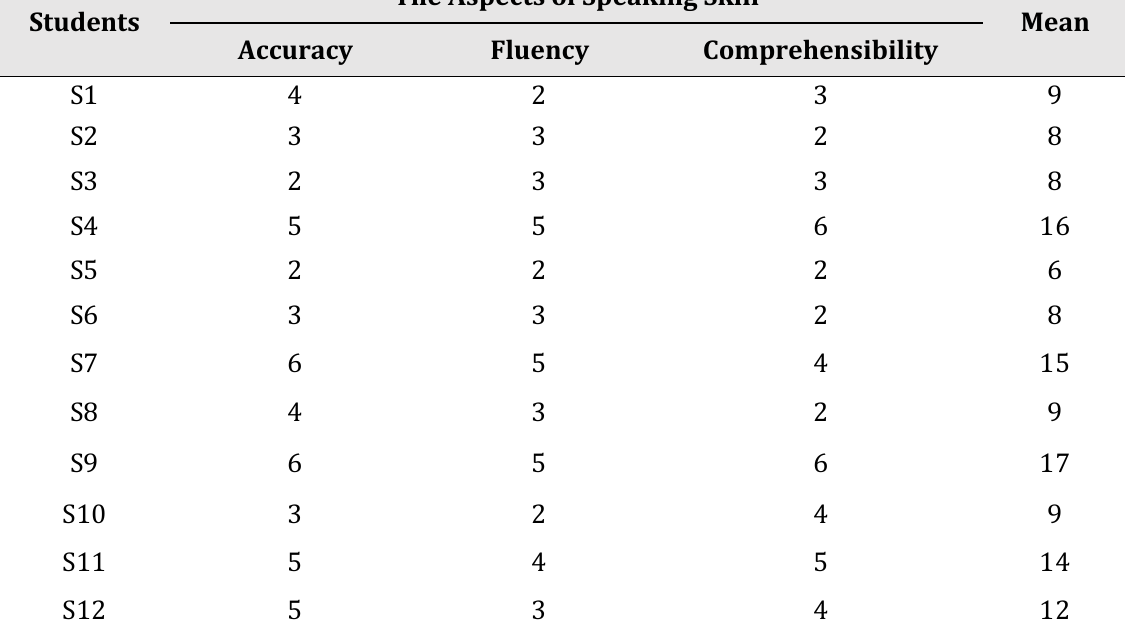
Table 12. Learners’